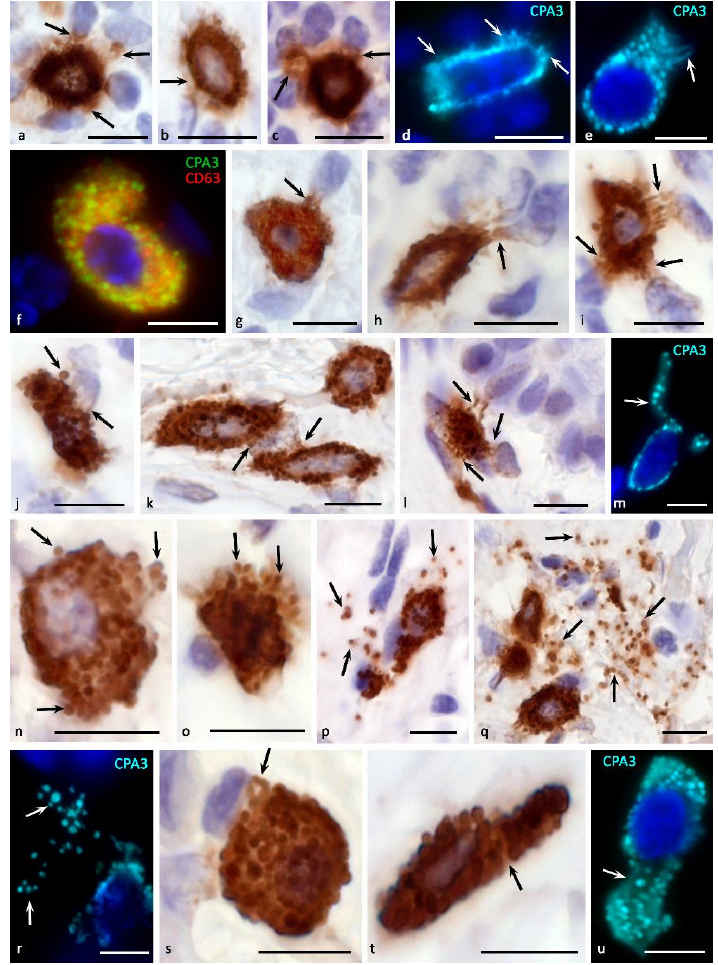
Figure 4. Morphological equivalents of mast cell CPA3 secretory pathways. Primary antibodies used: Rabbit polyclonal to CPA3 antibody (ab251696) ( a – u ) (AbCam), and Mouse monoclonal [NK1/C3] to CD63 antibody (ab1318) ( f ) (AbCam). Secondary antibodies used: ( a – c , g – l , n – q , s – t ) Am-